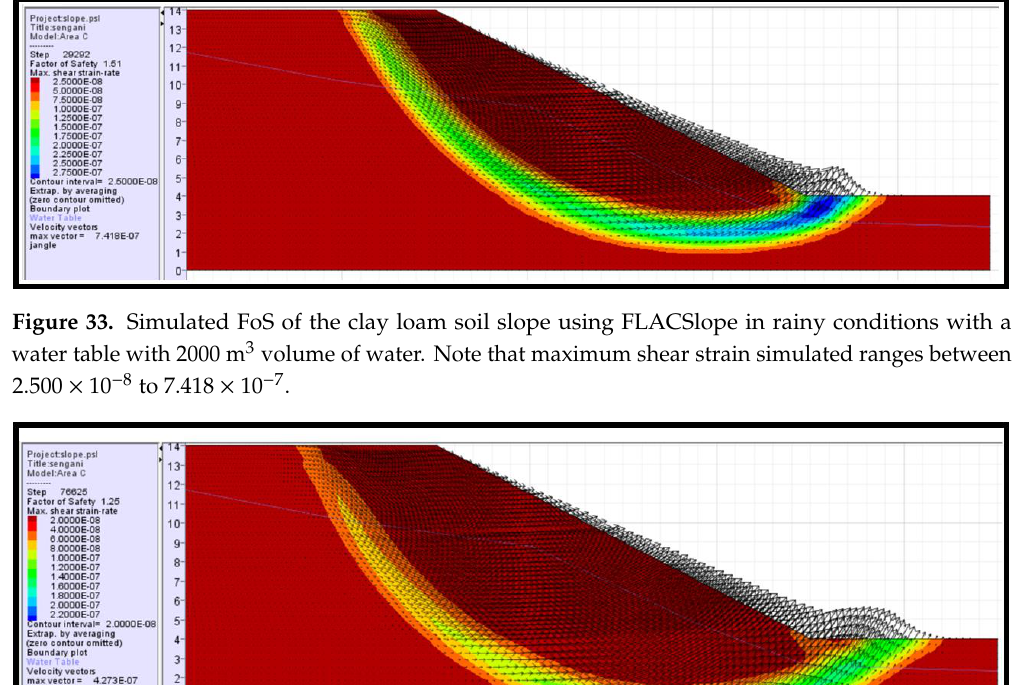
Figure 32. Simulated FoS of the clay loam soil slope using FLACSlope in rainy conditions with a water table with 1500 m 3 volume of water. Note that maximum shear strain simulated ranges between 1.0 × 10 − 8 to 2.833 × 10 − 7 .